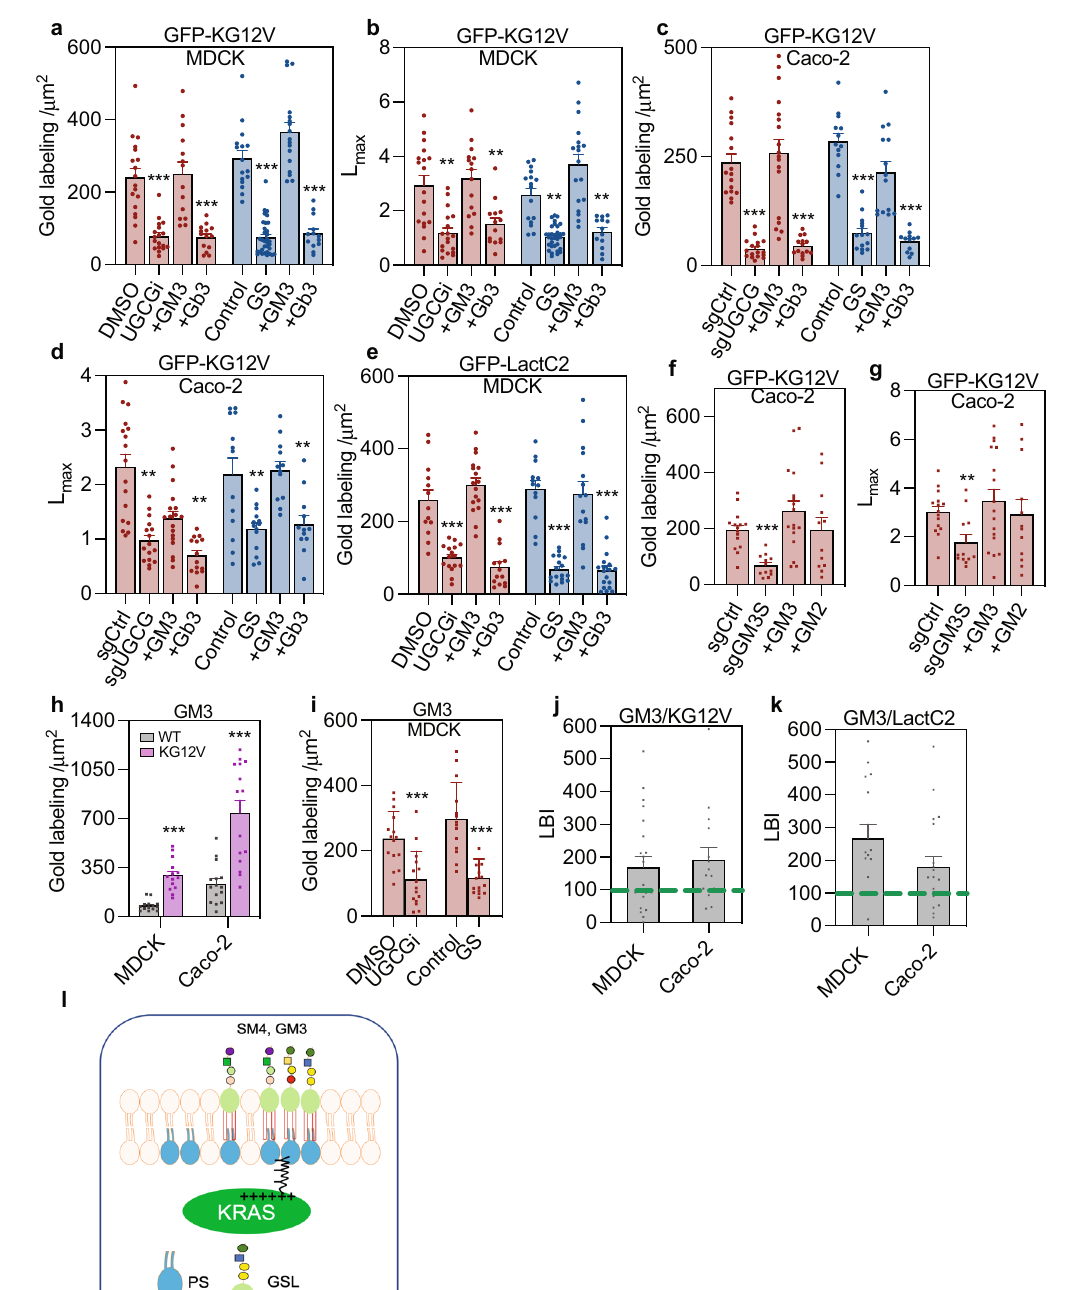
Fig. 4 | Coupling of outer lea fl et GM3 with inner lea fl et KRAS and PtdSer is critical for KRAS plasma membrane localization. a , b EM evaluation of PM sheets of MDCK cells stably expressing KRASG12V (KG12V) and treated with DL- PDMP (UGCGi) ( n =18 PM sheets), or cultured in glucose-depleted (GS) ( n =32) before incubated with exogenous GM3 ( n =14) or Gb3 ( n =14) for 1h. KRASG12V PM binding was quanti fi ed as mean gold labeling density and nanoclustering as L max . Comparisons are with cognate untreated control cells. c , d Identical GSL addback experiments and analyses to ( a ) and ( b ) in KRASG12V-expressing Caco-2 cells. e Identical GSL addback experiments to ( a ) in GFP-LactC2-expressing MDCK cells. f , g PM localization and nanoclustering of GFP-KRASG12V (KG12V) in Caco-2 cells depleted of GM3 synthase (sgGM3S) ( n =12) or expressing control vectors (sgCtrl) ( n =15) before incubation with GM3 ( n =17)or GM2 ( n =12) for 1h. h , i PM sheets from WT ( n =14) or KRASG12V-expressing ( n =15) MDCK or Caco-2 cells labeled with gold conjugated anti-GM3 antibodies and imaged by EM. PM GM3